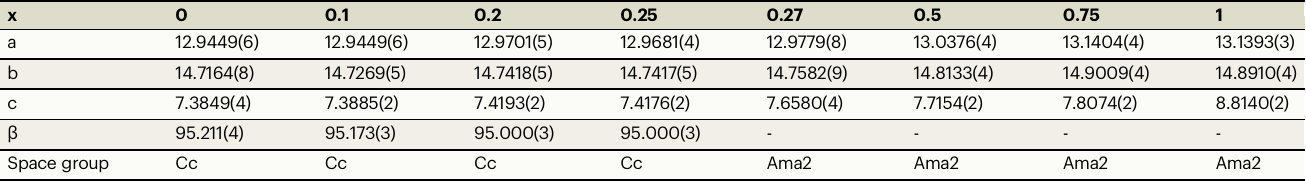
Table 1 | Structure information of this OIHF at room